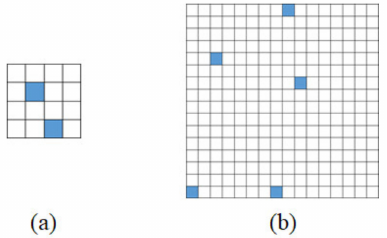
Figure 6. Examples of SDR according to total number of neurons and the number of activated neurons. ( a ) An example of only 2 activated neurons among 16 neurons, ( b ) An example of 5 activated neurons